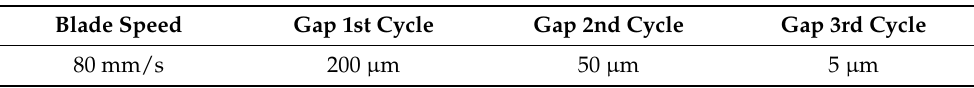
Table 3. Main settings of the squeegee setup for processing of Si substrates with the powders in Table 1.